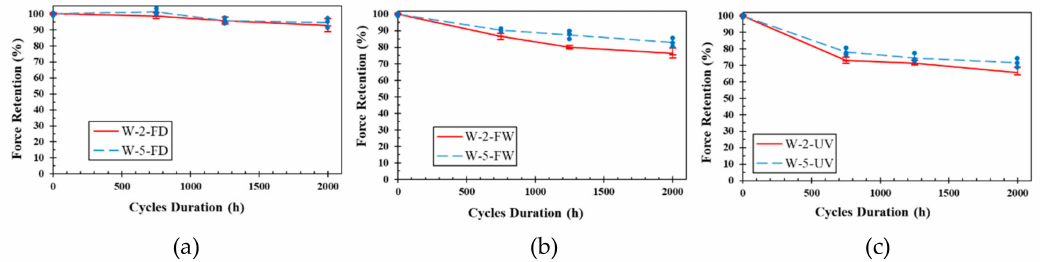
Figure 11. Retention ultimate tensile strength vs. exposure period of WL: ( a ) Dry freeze / thaw cycles, ( b ) wet freeze / thaw cycles and ( c ) UV and water vapor condensation cycles.